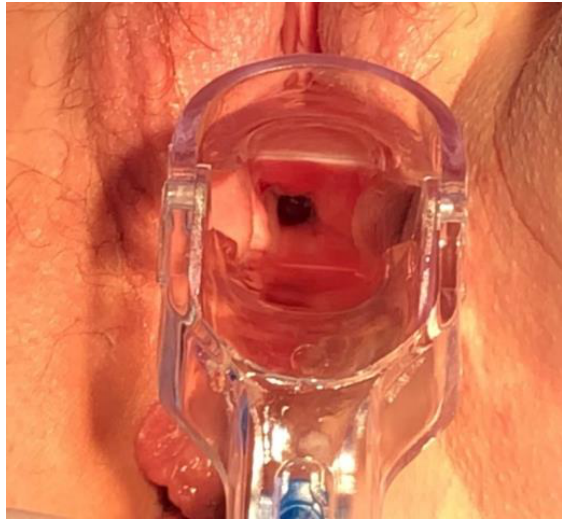
Figure 1. Vaginal orifice of the